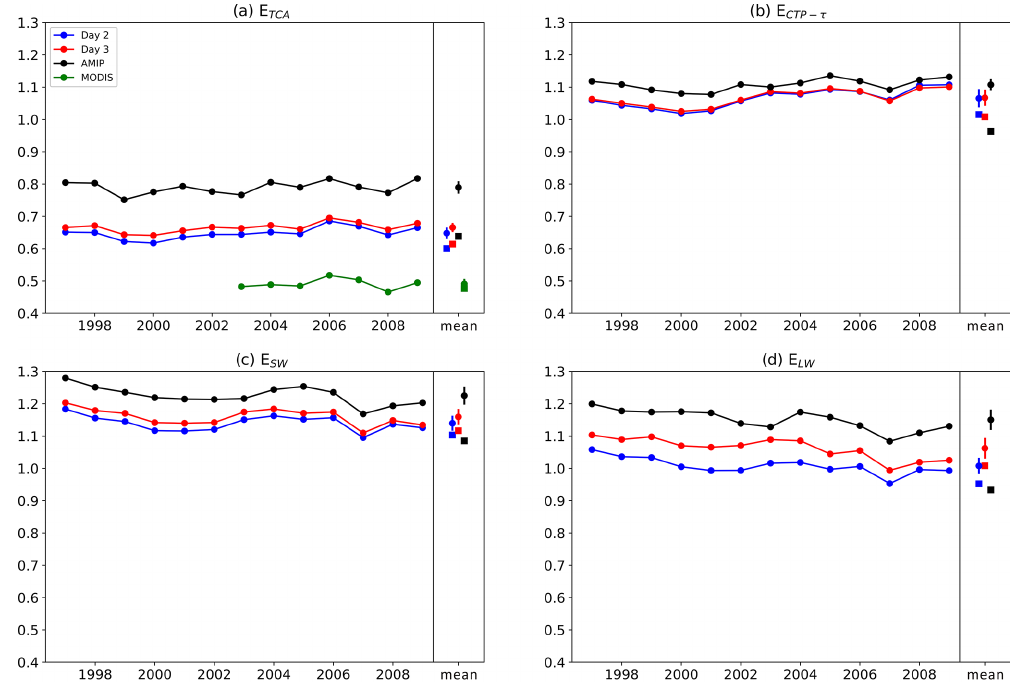
Figure 9. Cloud metrics as defined using the ISCCP simulator in Klein et al. (2013) for day 2 and 3 hindcasts, as well as the AMIP simulation. These metrics are scalar measures of performance in simulating the space–time distribution of several cloud measures, with better performance indicated by smaller E values. E TCA measures total cloud amount, and E CTP − τ measures cloud-top pressure and optical depth in different categories of optically intermediate and thick clouds at high, middle, and low levels of the atmosphere. E SW and E LW measure the impacts on top-of-atmosphere shortwave and longwave radiation in the same categories used for E CTP − τ , respectively. The markers with error bars show the average and 1 σ interannual variation in these error metrics. The square symbols are the error metrics computed by comparing model and observed monthly resolved climatological means. MODIS cloud amount for E TCA is plotted as a measure of observational